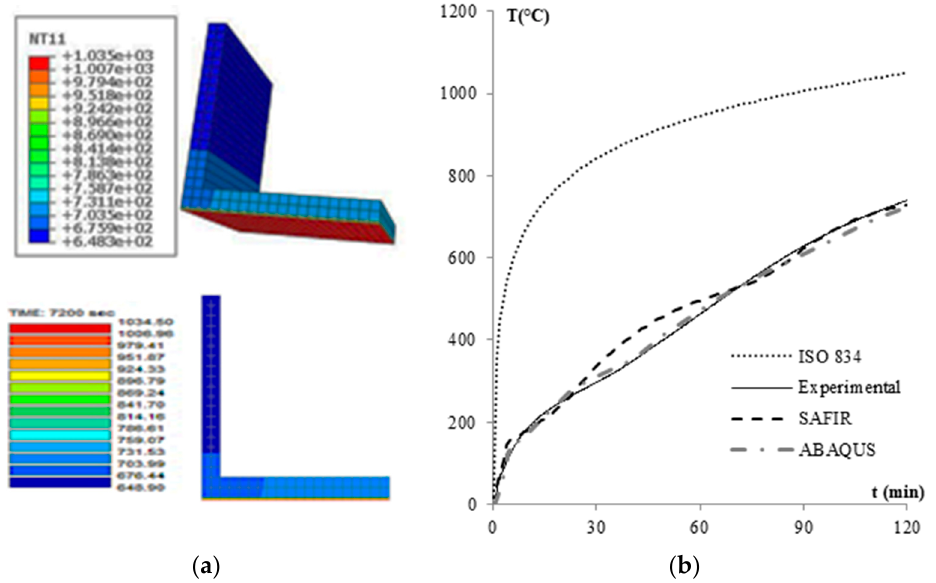
Figure 9. Test data and analytical results for Intumescent Coating test: ( a ) Results at the end of 120 min of analytical modelling, ( b ) Comparison of analytical results and the test data.